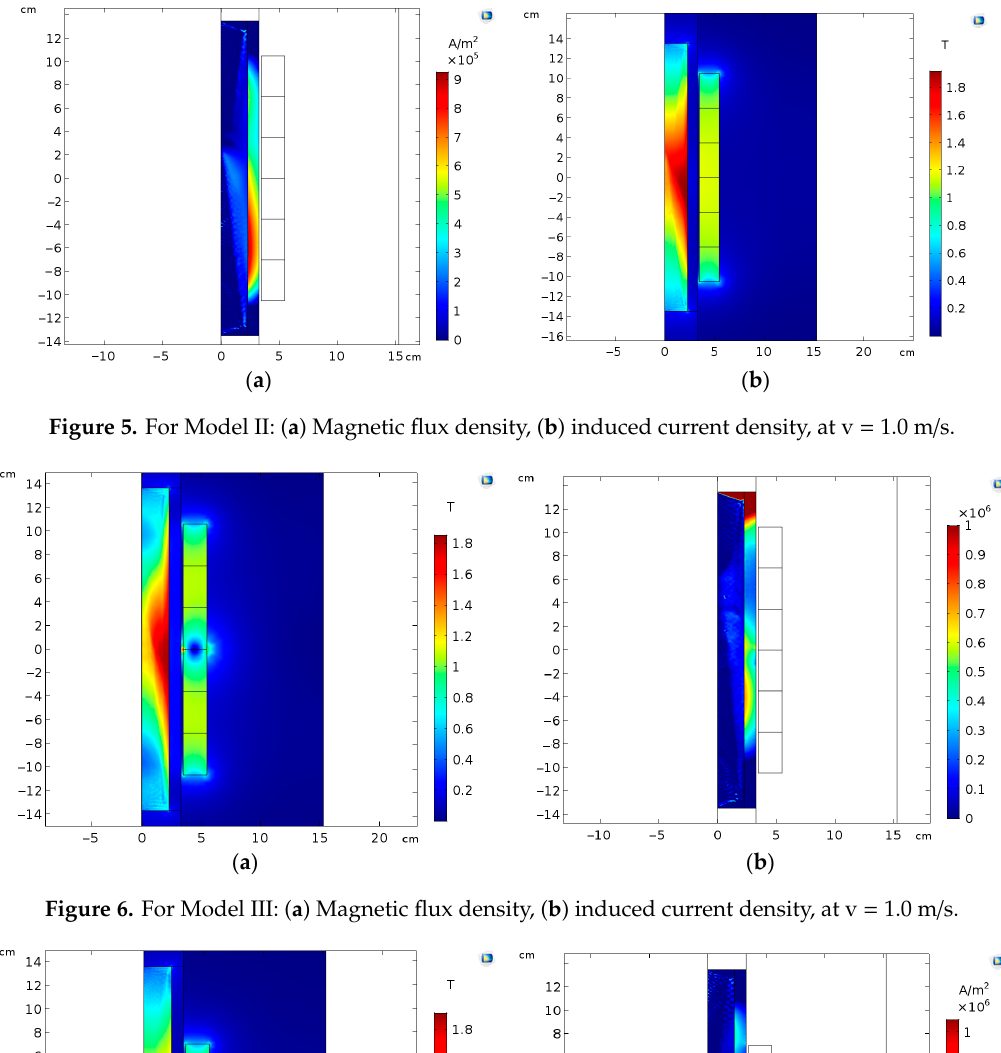
Figure 4. For Model I: ( a ) Magnetic flux density, ( b ) induced current density, at v = 1.0 m/s.